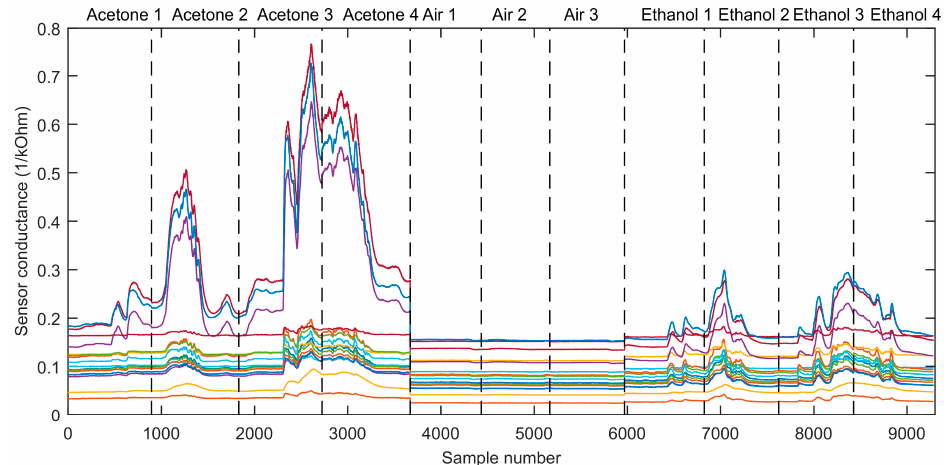
Figure 5. Measured sensor conductance obtained with the 16-element MOX sensor array when the APR traveled through the arena and reached the gas plume for ethanol and acetone.